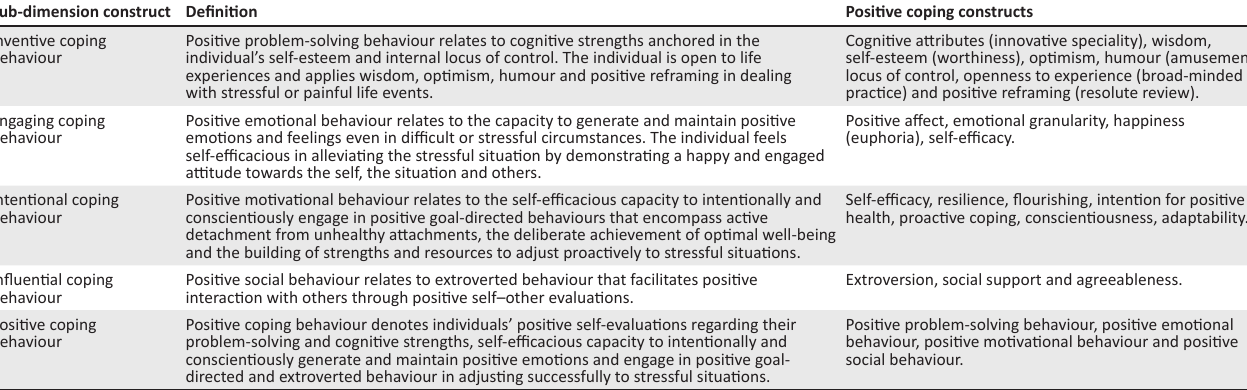
TABLE 1: Four-factor constructs and definitions of the 41-item positive coping behavioural inventory. Sub-dimension construct Definition Positive coping